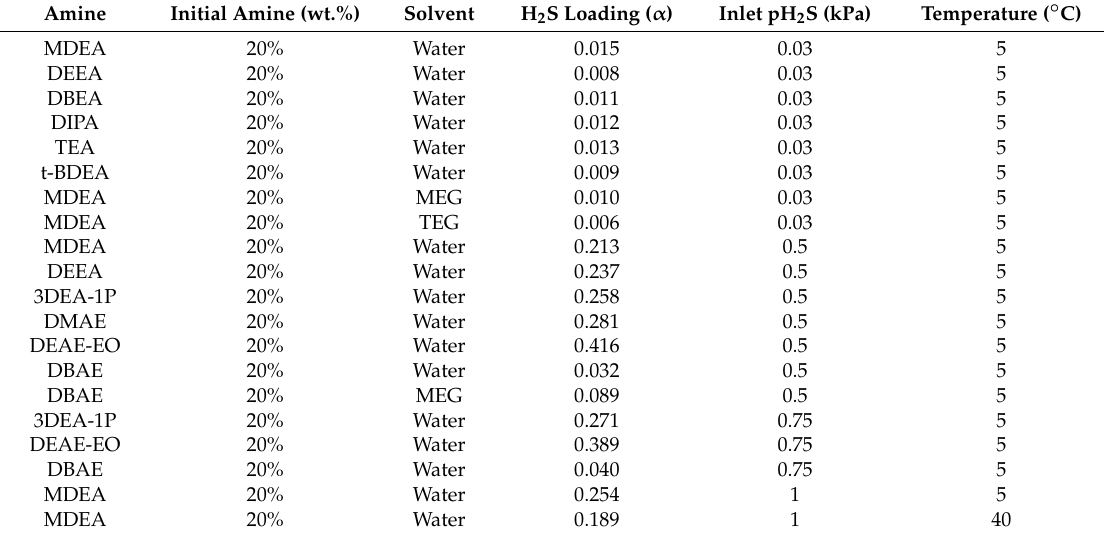
Table 2. Experimental